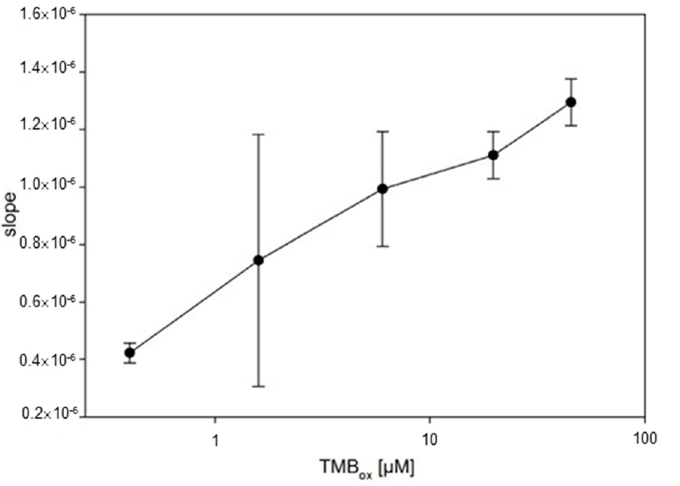
Figure 5. Concentration of oxidized TMB plotted against the slope of the regression lines ( n =